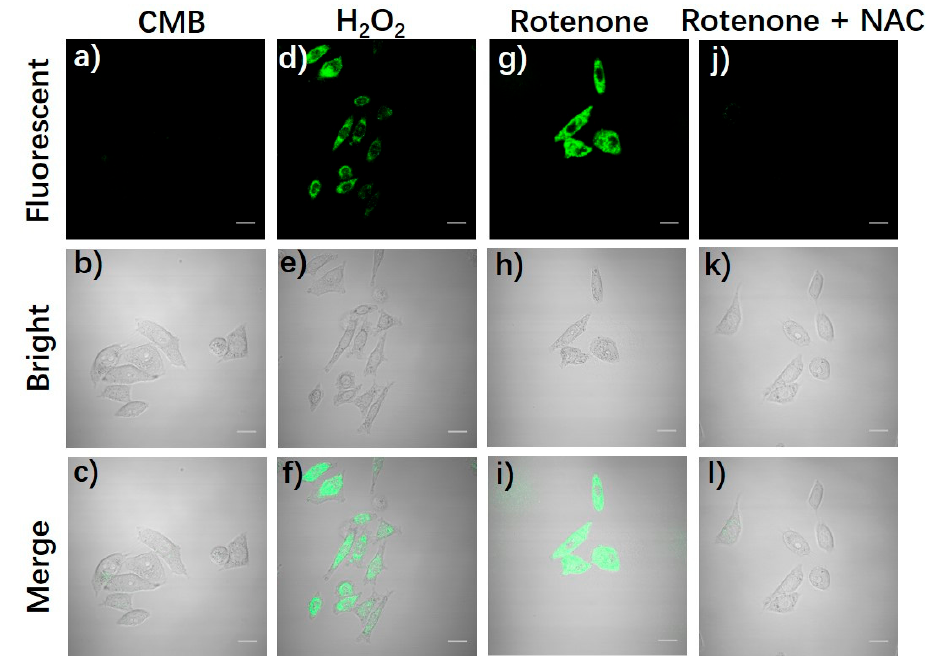
Figure 6. Confocal images for exogenous and endogenous H 2 O 2 in MCF-7 cells. ( a – c ) Cells were stained with CMB (2 μ M). ( d – f ) Cells were incubated with H 2 O 2 and then stained with CMB (2 μ M). ( g – i ) Cells were incubated with rotenone and then stained with CMB (2 μ M). ( j – l ) Cells were incubated with rotenone, treated with NAC, and then stained with CMB (2 μ M). The excitation wavelength was 405 nm and the emission was collected at 420 to 520 nm. Scale bar = 20 μ m.